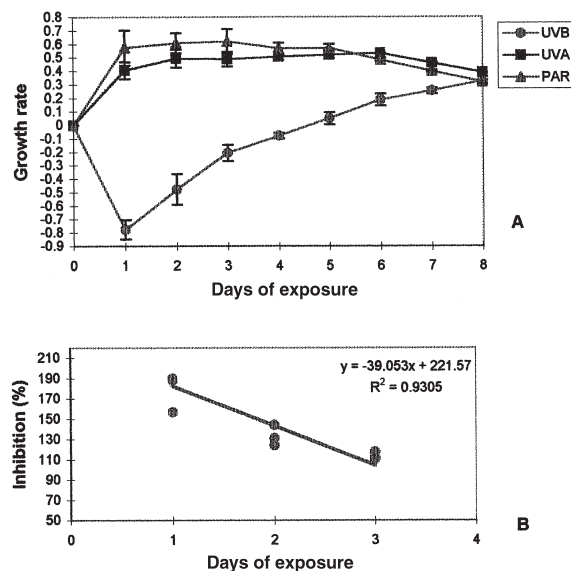
data is due primarily to changes in the degree of cloud cover. Experiment with monospecific cultures The specific growth rate (K) corresponding to the different treatments of the Navicula sp . are shown in Figure 3. There were no significant differ- ences (p>0.05) between treatments (Table 1). At day 4 of exposure, K values were significantly higher (p<0.01) than those calculated for the first day of the experiment (Table